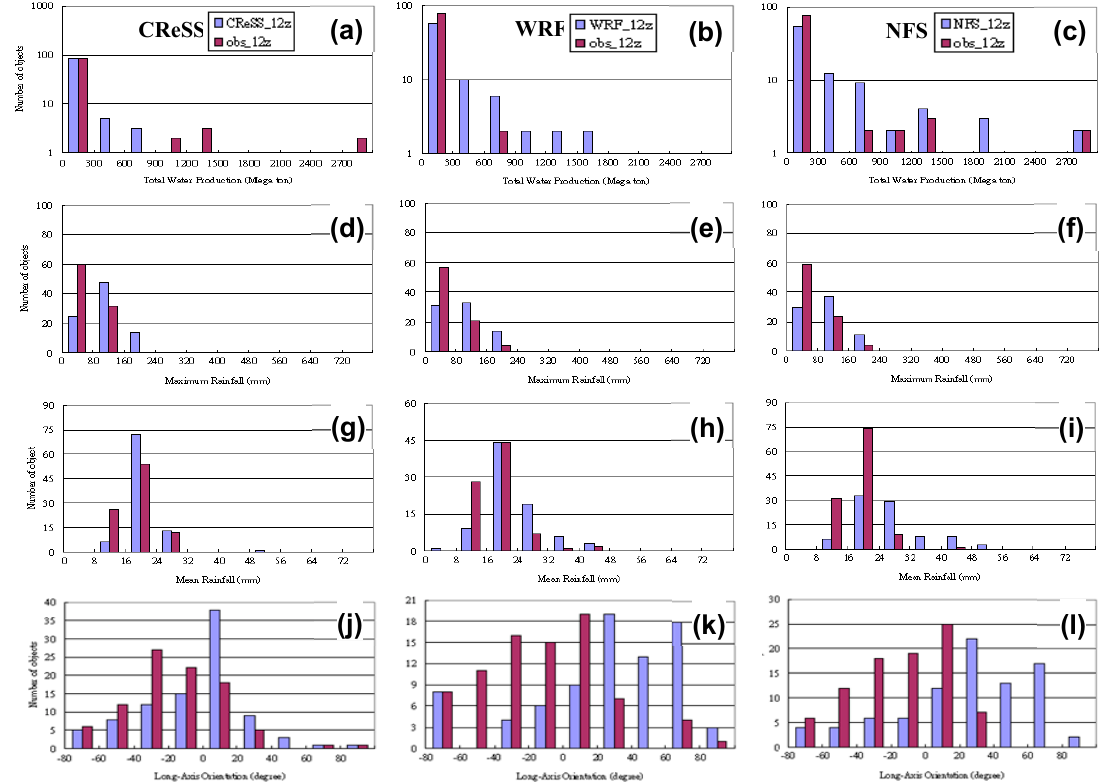
Figure 6. ( a – i ) As in Figure 4a–i and ( j – l ) as in Figure 5m–o, but for (12–36 h) forecasts initialized daily at 1200 UTC. The number of objects successfully paired with observation is 92, 82, and 87, respectively, for CReSS, WRF, and NFS. Note that in some panels, the scales in vertical axis are different.